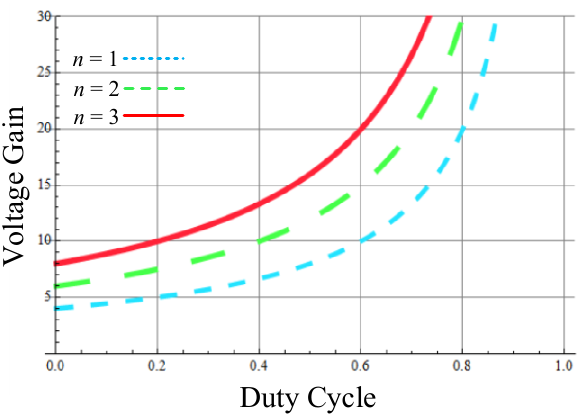
Figure 6. Illustration of voltage gain versus duty cycle under different turns ratios.